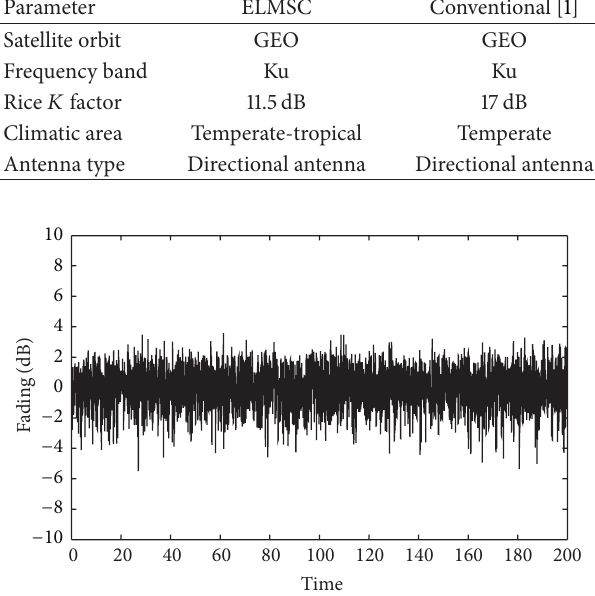
Figure 7: Fading in the clear LOS state.